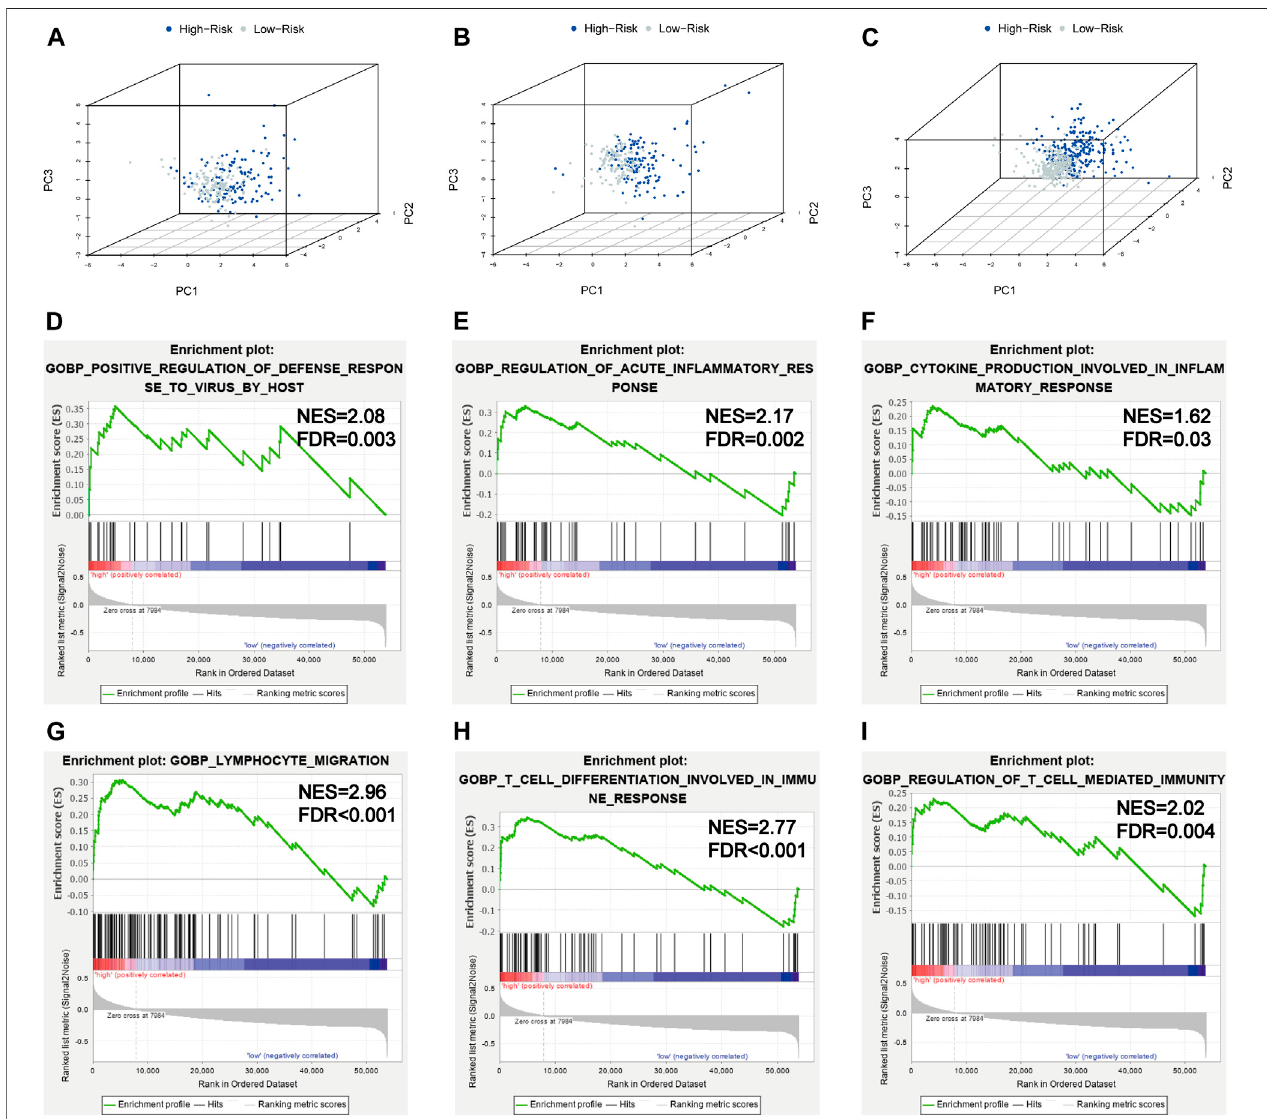
FIGURE 8 | PCA and GSEA analyses. (A – C) PCA plots of the training set, testing set, and entire TCGA-KIRC cohort; (D – I) GSEA analyses for the biological processes in the entire TCGA-KIRC